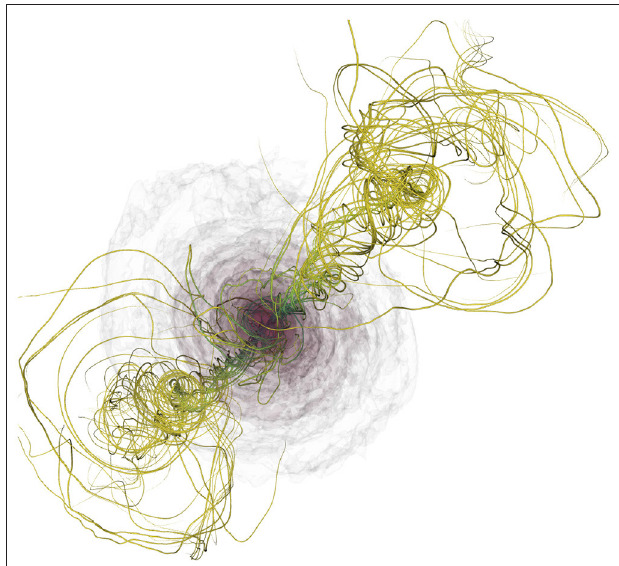
FIGURE 2 | Collimated helical magnetic field structure emerging along the spin axis of a long-lived BNS merger remnant (from a simulation presented in Ciolfi, 2020a). Several semi-transparent isodensity surfaces are also shown for the highest rest-mass density region (with density increasing from gray to